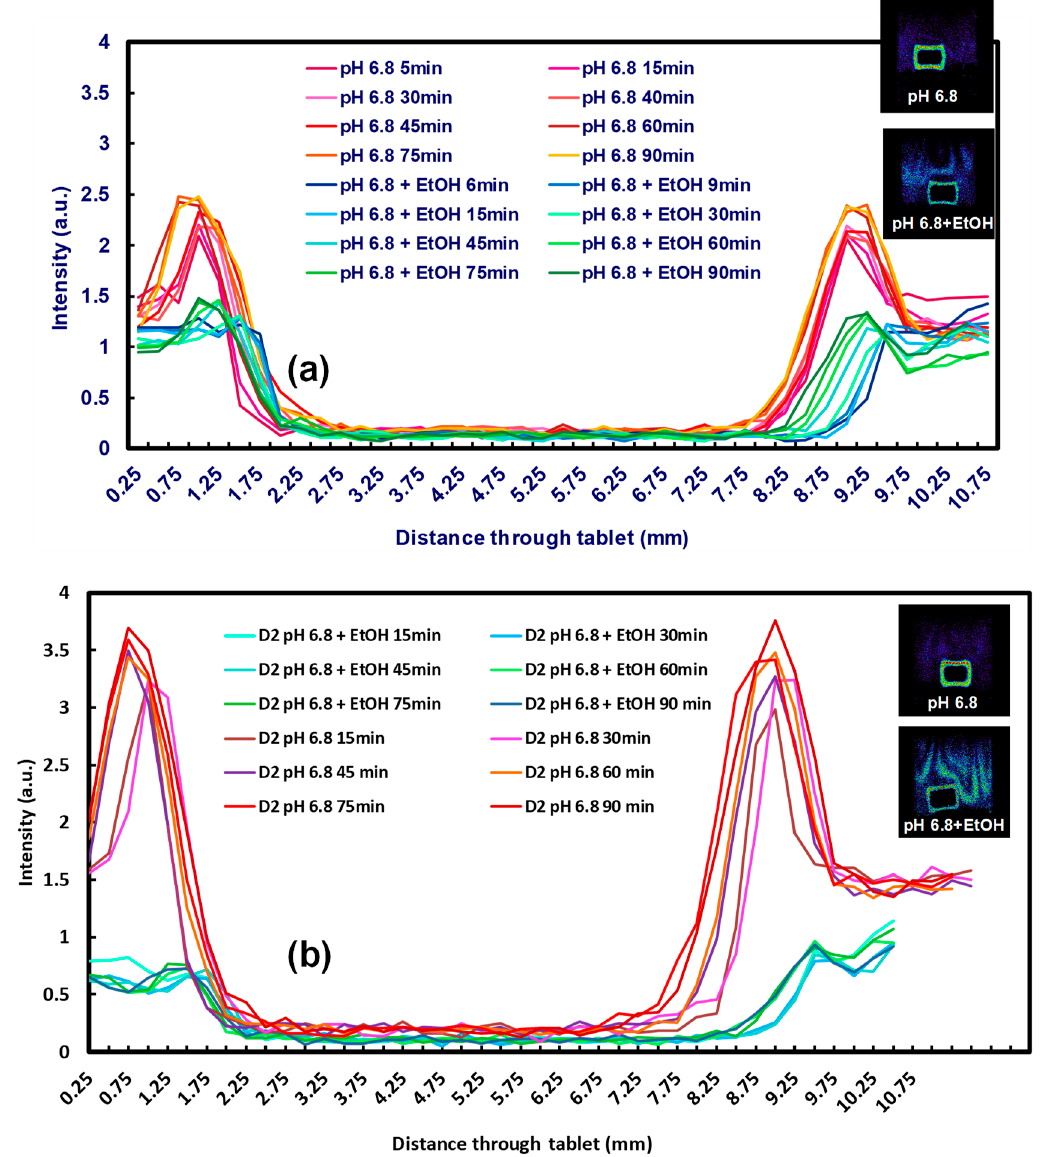
Figure 9. One-dimensional profiling of ( a ) CR grade compact in pH 6.8 medium every 5 min for 90 min in the presence and absence of alcohol (128 matrix, 500 ms, 6 ms), ( b ) DC grade tablet compact in pH 6.8 every 5 min for 90 min in the presence and absence of alcohol content (128 matrix, 500 ms, 6 ms).